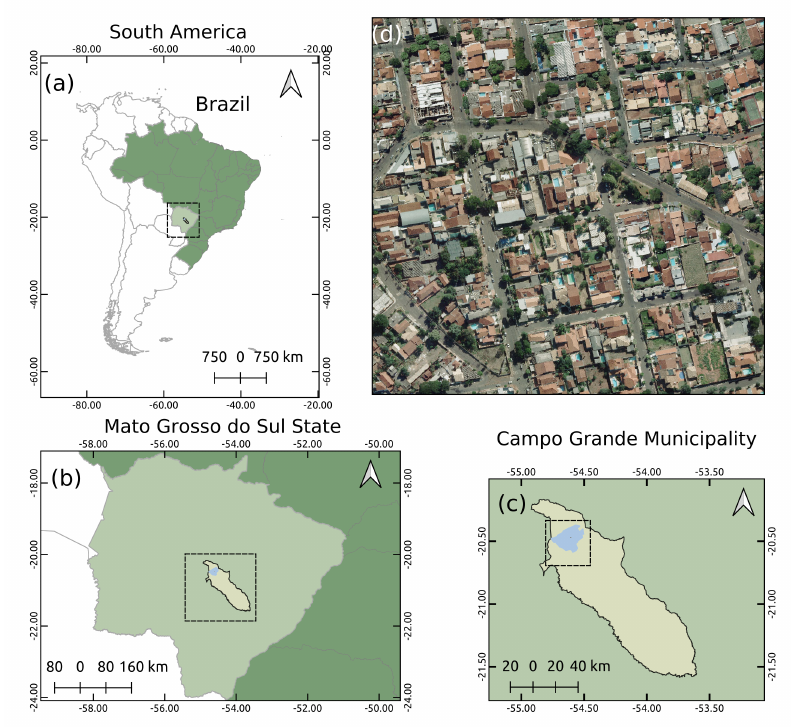
Figure 1. Study area in ( a ) South America and Brazil, ( b ) Mato Grosso do Sul, ( c ) Campo Grande, and ( d ) an example of an orthoimage used in this study.